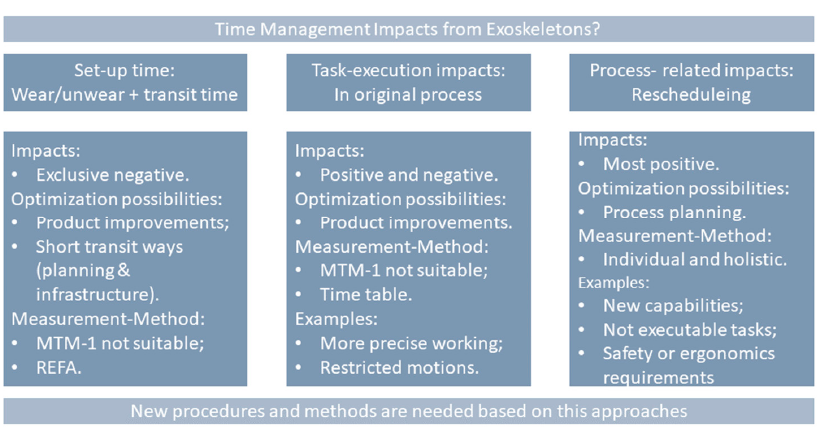
Figure 6. Three categories of time-management impacts for exoskeleton integration [4].